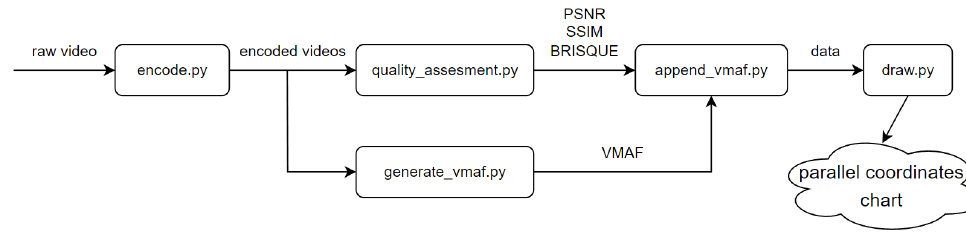
Figure 1. Script execution